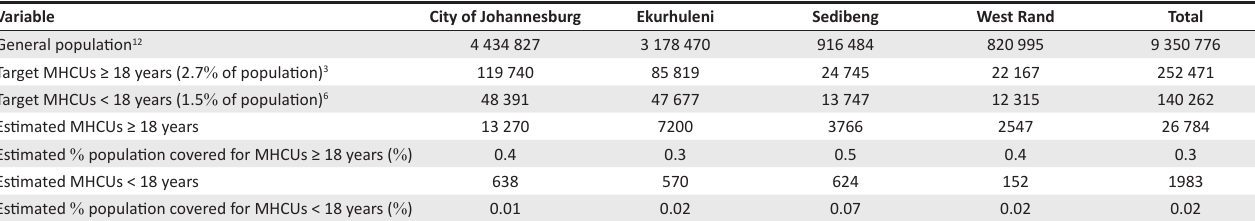
FIGURE 1: Referral source for the Community Mental Health Services of each district. TABLE 2: Estimated number of mental health care users attending the Community Mental Health Services with respect to population. Variable